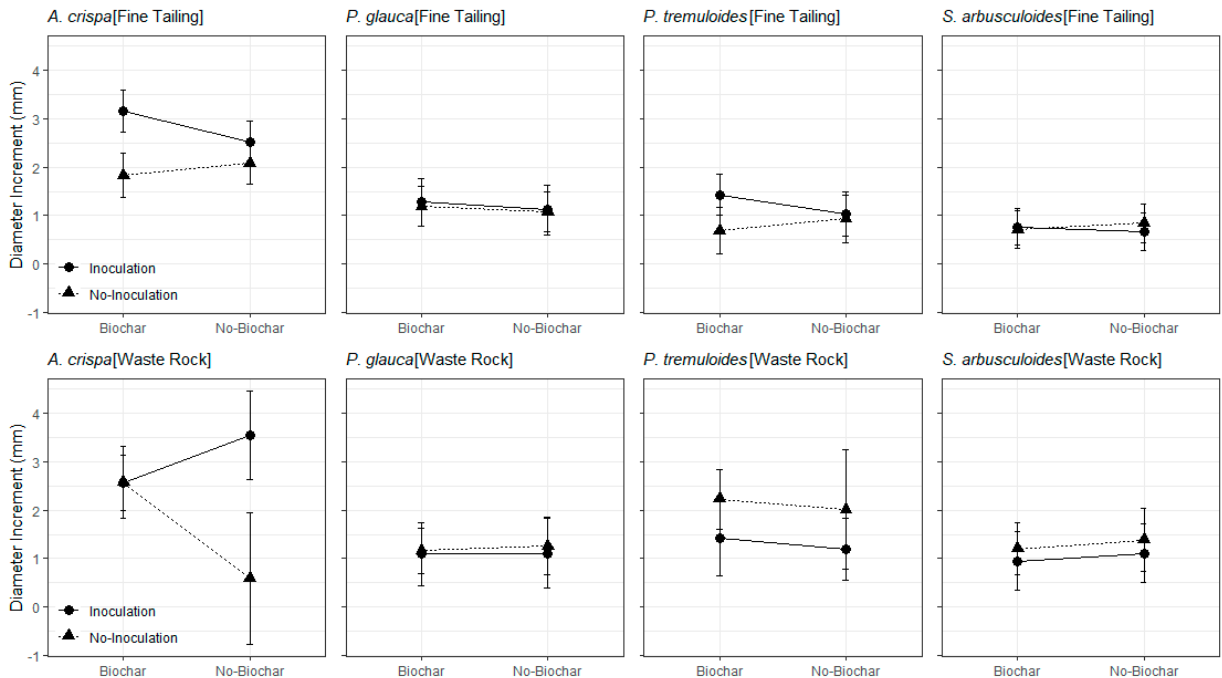
Figure 6. The marginal interaction effect of plant species, tailing, biochar, and inoculation treatment on plant diameter increments. The error bars represent the 95% con fi dence interval (CI) of means.